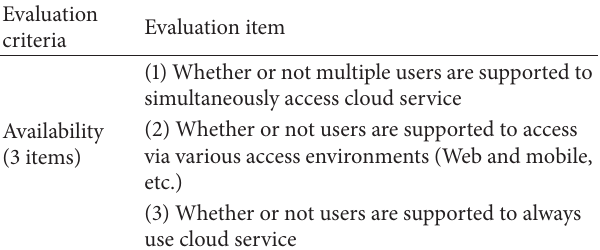
Table 3: Evaluation items of